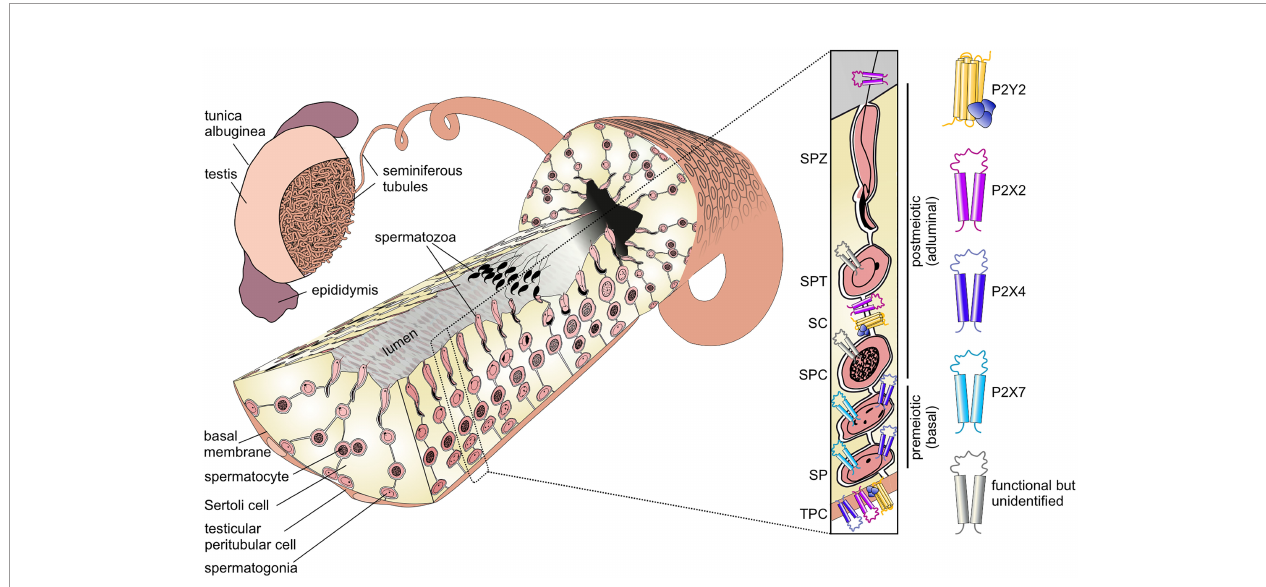
FIGURE 1 | Functional P2 receptor isoform distribution among individual cell types of the seminiferous tubule. Left: Schematic illustration of the mammalian testis and cellular architecture of a seminiferous tubule. A single layer of contractile testicular peritubular cells (TPC) lines the tubular wall. Developing germ cells are distributed between nourishing Sertoli cells (SCs). Undifferentiated spermatogonia (SP) are located near the basal membrane. Spermatocytes (SPC) migrate to the adluminal compartment, where they complete meiosis. The resulting haploid round spermatids (SPT) differentiate into elongated spermatids and, eventually, into highly condensed and compartmentalized spermatozoa (SPZ). These mature, yet immotile spermatozoa are then released into the lumen (spermiation) and undergo further maturation steps once transported to the epididymis. Adapted from: Fleck, Kenzler et al. (3). Right: Distribution of P2 isoforms in various cell types of the seminiferous tubule. Schematic shows the P2 receptor distribution as supported by direct functional (i.e., physiological)